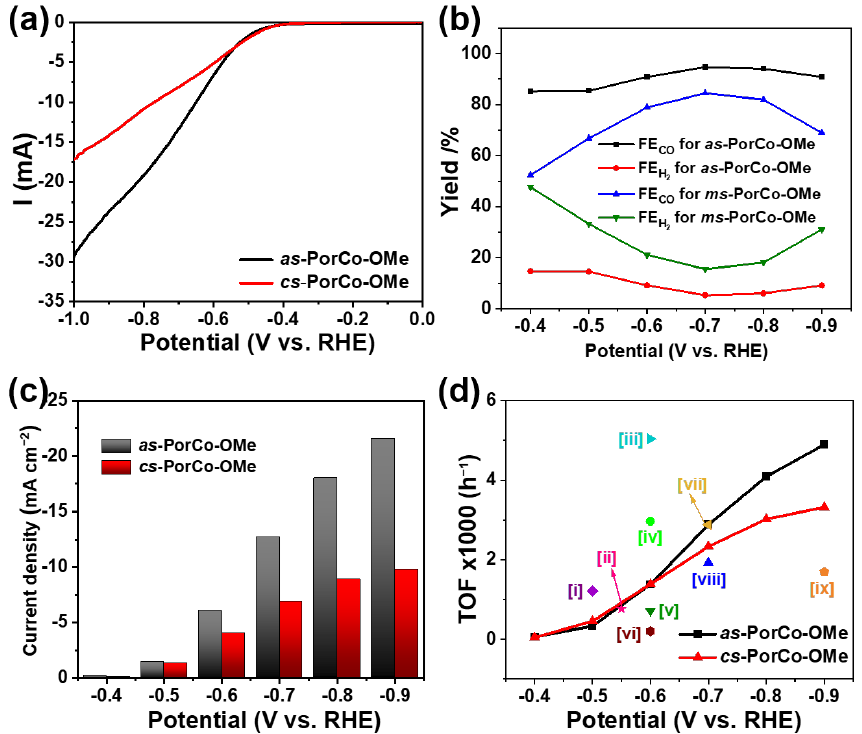
Figure 5. ( a ) LSV curves of as -PorCo-OMe and cs -PorCo-OMe in CO 2 -saturated 0.5 M KHCO 3 electrolyte (scan rate: 5 mV s − 1 ); ( b ) FE CO and FE H2 of of as -PorCo-OMe and cs -PorCo-OMe at various specific potentials; ( c ) CO partial current densities at various specific potentials; ( d ) Comparison of TOF of as-prepared complex with various porphyrin-based electrocatalysts of [i] PorFe-MOF [47], [ii] COF-367-PorCo (1%) [10], [iii] PorCo/cationic POP [48], [iv] as -PorCo [29], [v] CoTMPP